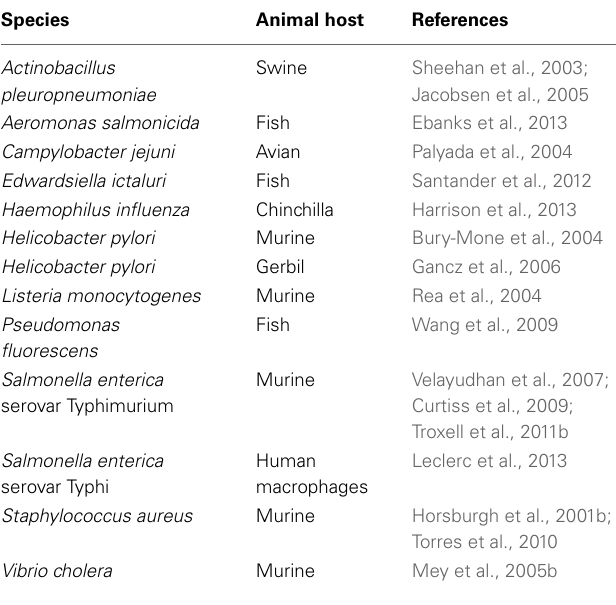
Table 1 | Animal models of infection that require Fur for